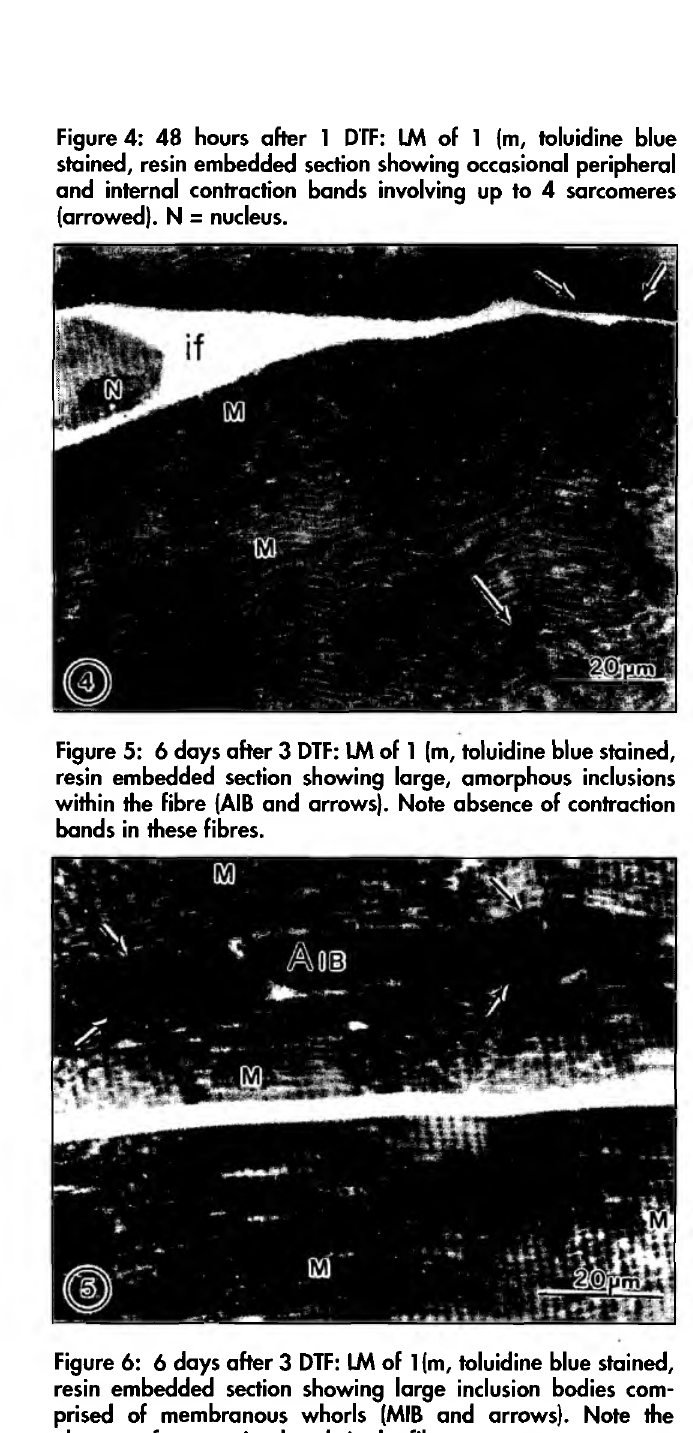
Figure 6: 6 days after 3 DTF: LM of 1 (m, toluidine blue stained, resin embedded section showing large inclusion bodies com­ prised of membranous whorls (MIB and arrows). Note the absence of contraction bands in the